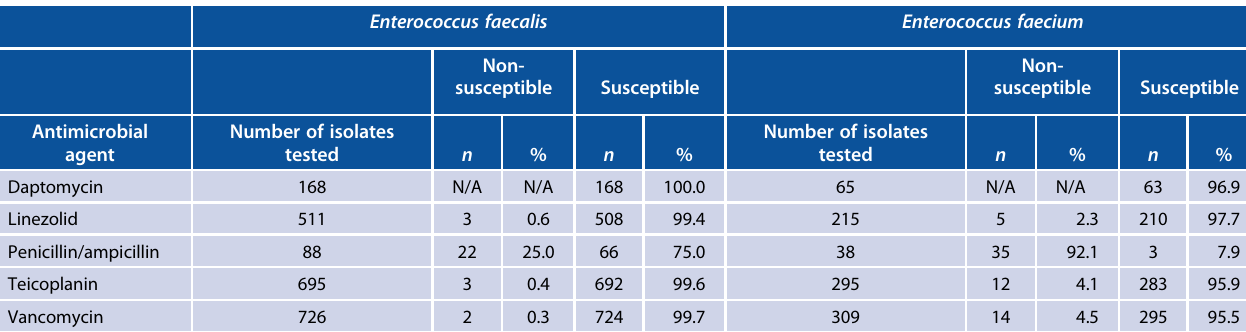
Table 3: Antimicrobial susceptibility patterns of enterococci species isolated from blood cultures reported from four private groups in South Africa, January 1, 2016 to December 31, 2016